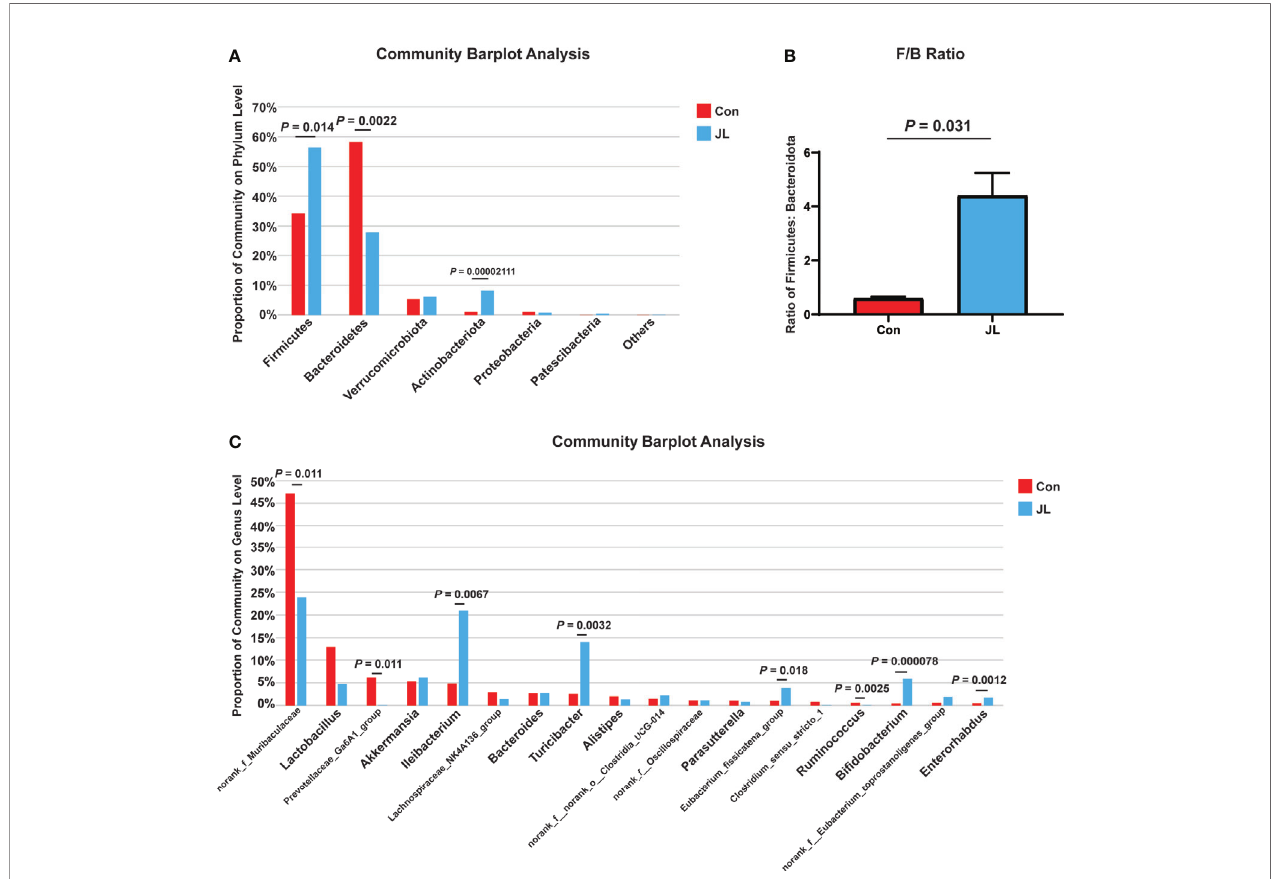
FIGURE 2 | The differences of colonic microbiota between Con (n = 6) and JL (n = 5) groups. (A) Community barplot on phylum level of each group. (B) Ratio of Firmicutes to Bacteroidota. (C) Community barplot on genus level (top 18) of Con and JL groups. Differences were assessed by student ’ s t